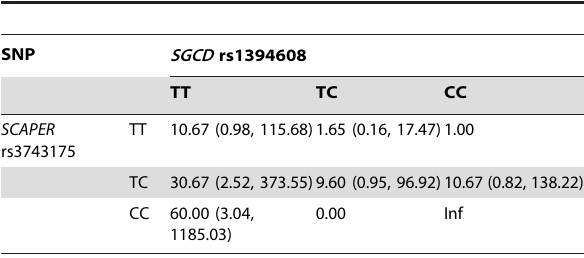
Table 3. p -values for SNPs with posterior probabilities greater than or equal to